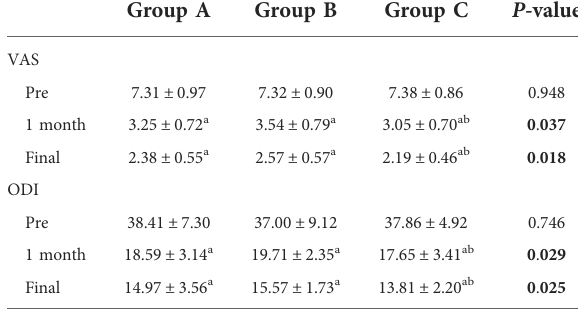
TABLE 1 The demographic data of groups.